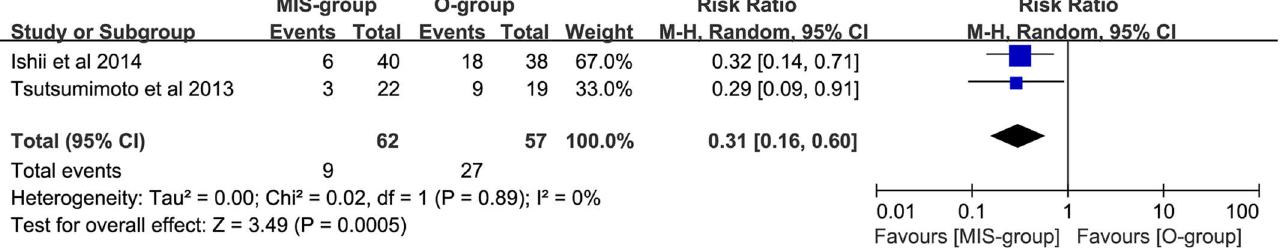
Fig 5. The comparing of radiograph ASDeg incident rate between MIS and open groups.